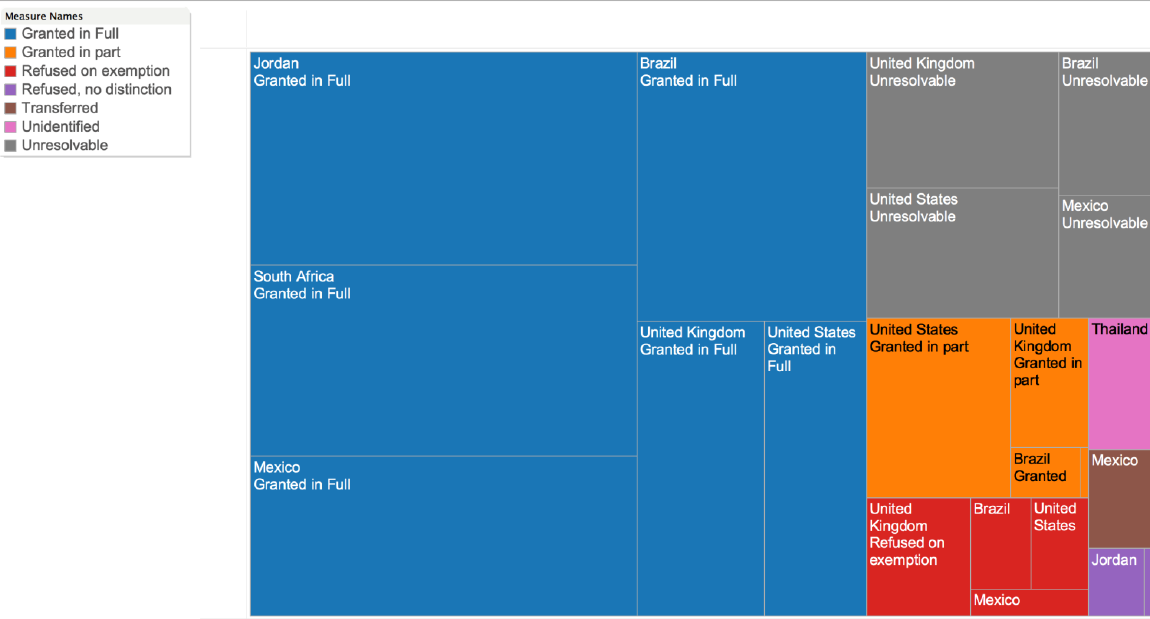
The colour of each rectangle indicates the class of disposition (e.g., granted in full). The meaning of each colour is explained in the key in the upper left-hand corner of the figure. The size of each rectangle indicates the volume of requests by class of disposition. Each rectangle is also tagged with the name of the country to which it refers. The figure identifies that Jordan, South Africa and Mexico had the highest volume of requests granted in